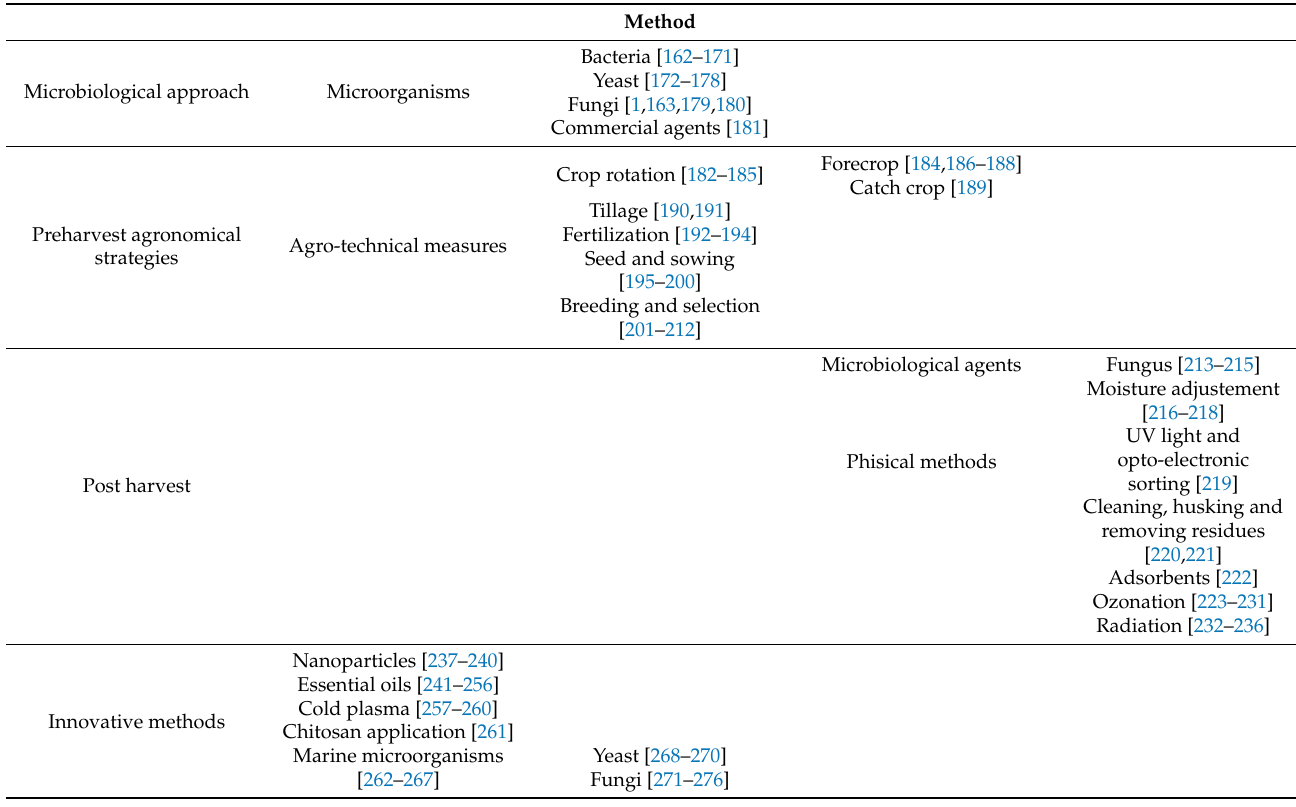
Table 3. A short overview of biocontrol methods presented in this